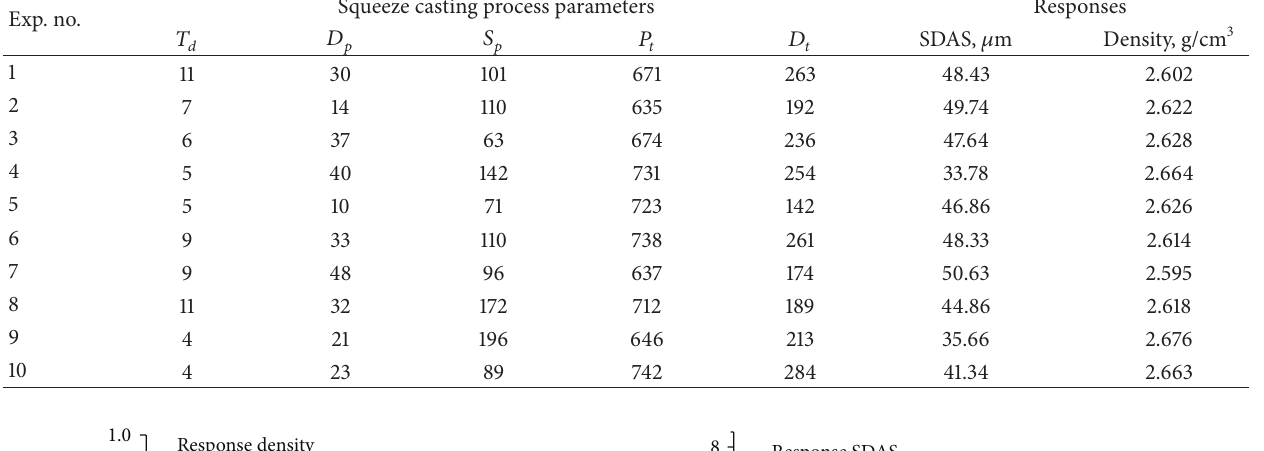
Table 5: Summary results of input-output results of the test cases. Exp. no.